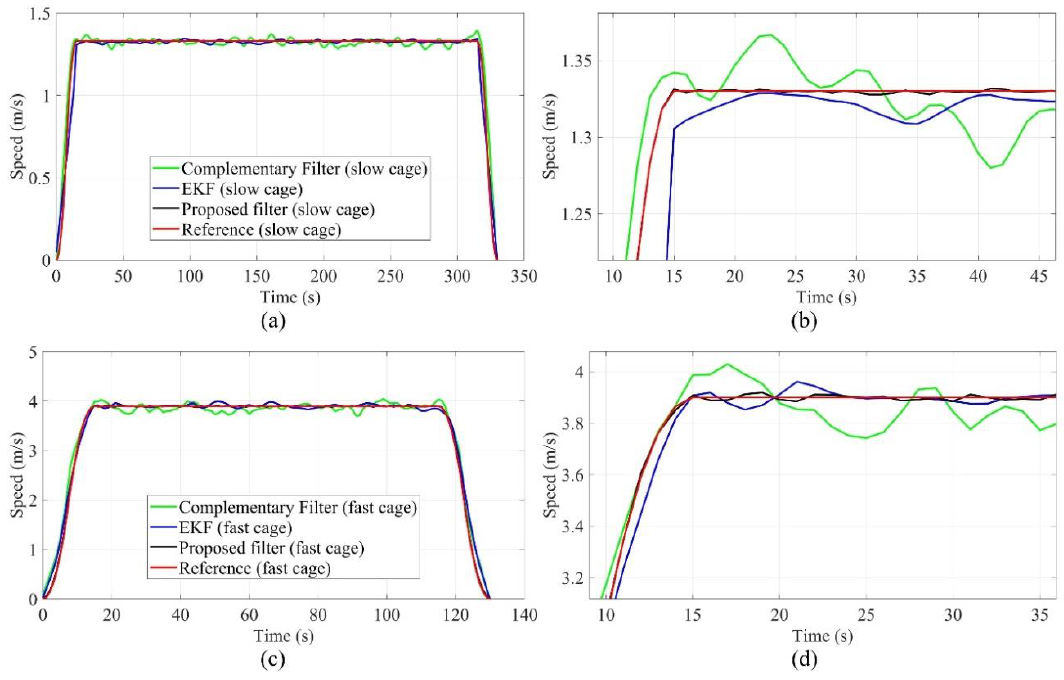
Figure 17. Speed tracking test of the hoisting cage ( a ) speed tracking of the slow cage; ( b ) part details of speed tracking for the slow cage; ( c ) speed tracking of the fast cage; ( d ) part details of speed tracking for the fast cage.